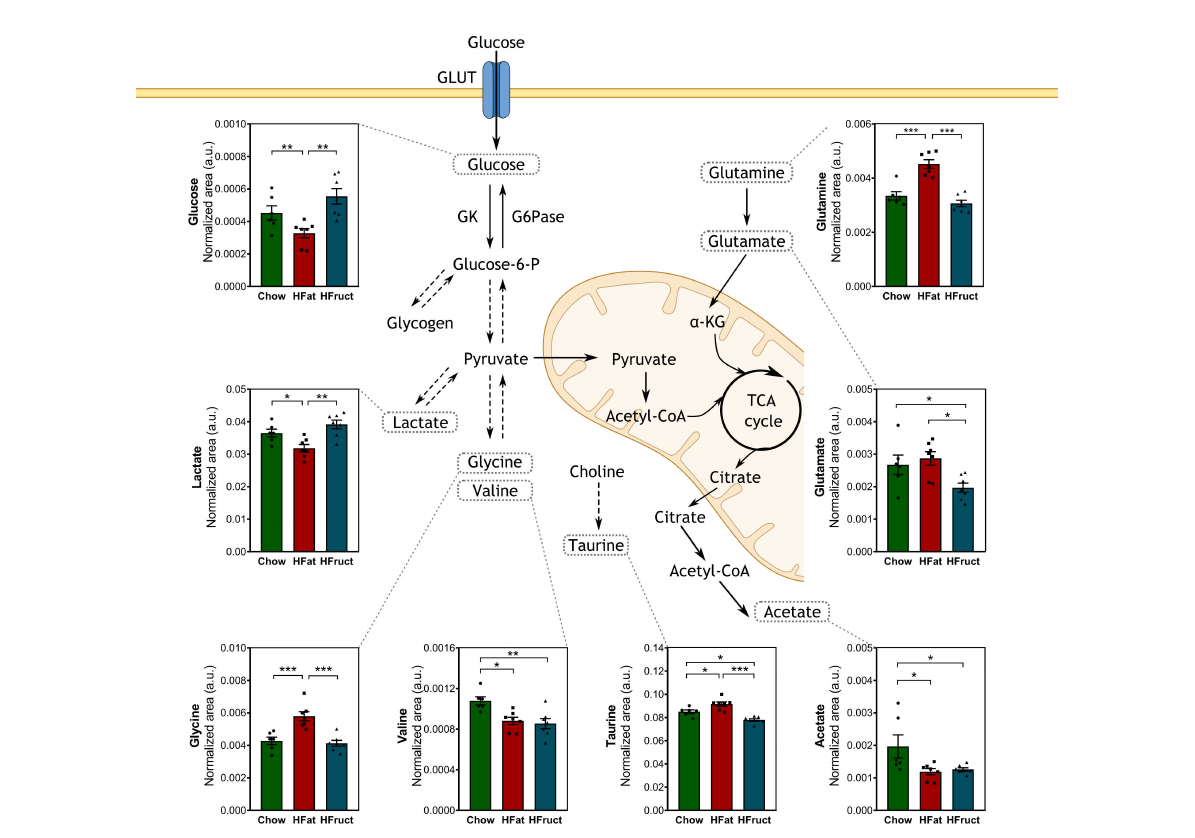
FIGURE 3 Effects of the HFat and HFruct diets on the muscle metabolism of C57Bl/6J male mice. Chow, high-fat (HFat), and high-fructose (HFruct) muscle levels of metabolites involved in glycolysis/gluconeogenesis and amino acid metabolism. a -KG, a -ketoglutarate; G6Pase, glucose-6- phosphatase; GK, glucokinase; GLUT, glucose transporter; IMP, inosine monophosphate; TCA, tricarboxylic acid. Data are presented as mean ± SEM for fi ve to seven mice. *p<0.05, **p<0.01;